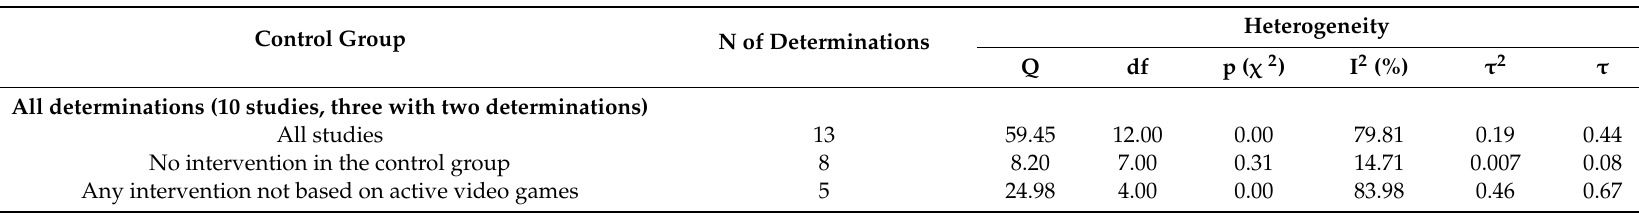
All determinations (10 studies, three with two